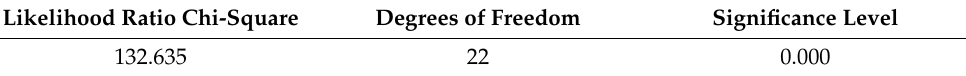
Table 4. Results from the overall model.